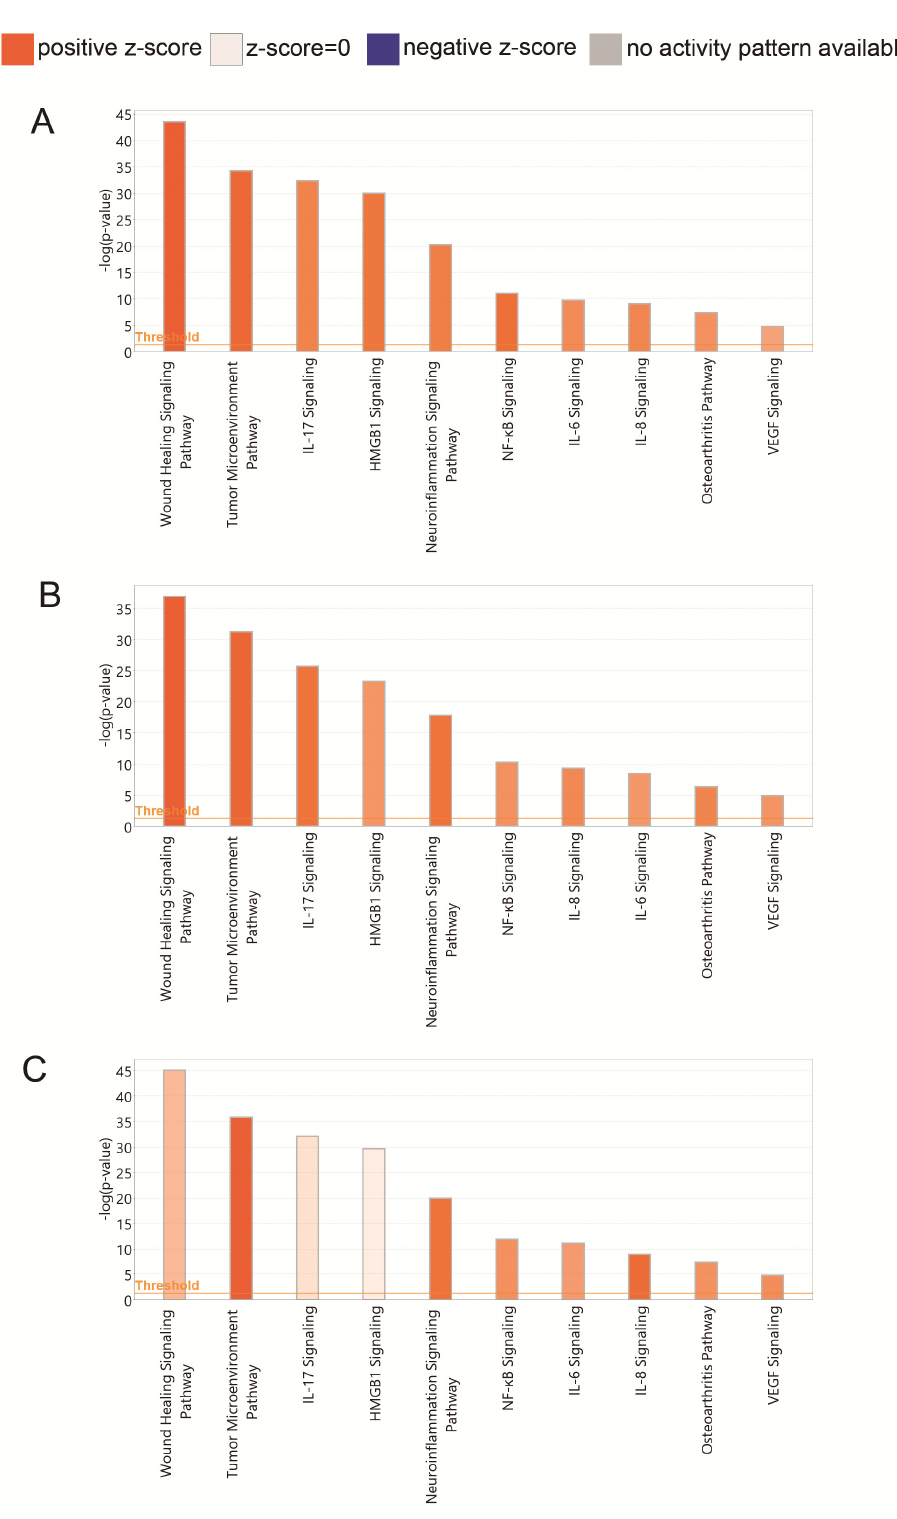
Figure 5. Functional pathways represented in the data: ( A ) predictions of canonical pathways activation for protein fold changes obtained with biobank plasma (PRP vs. PPP). ( B ) Same for in-house prepared plasmas. ( C ) Same for in-house prepared supernatants (collected 1 h after CaCl 2 activation) p -values < 0.05 indicate non-random association between our experimental datasets and functions/pathways. (Fold changes for each preparation procedure are shown in Table S1). The colors of the bars represent IPA’s z -score, which predicts pathway activation or inhibition.